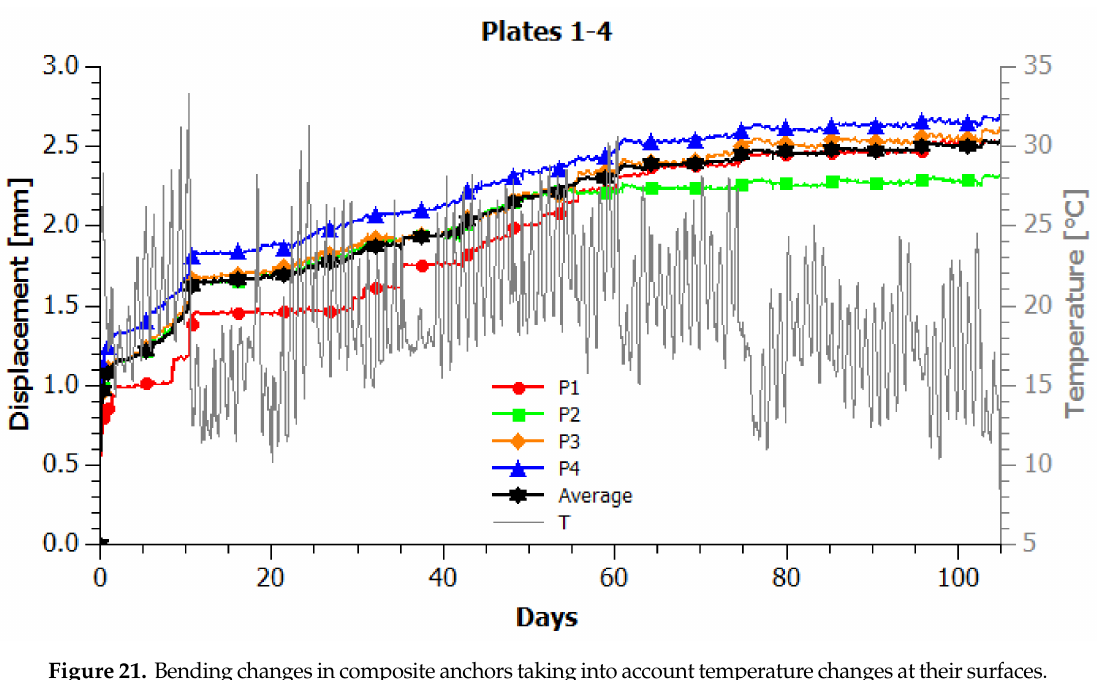
Figure 21. Bending changes in composite anchors taking into account temperature changes at their surfaces.